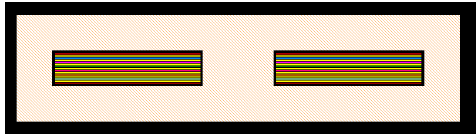
Figure 21. Design I: forward-type transformer for m = 215: planar E-core and 200 µ m copper Figure 20. Design I: forward-type transformer for 𝑚 = 215 : planar E-core and 200 μ m copper foil.